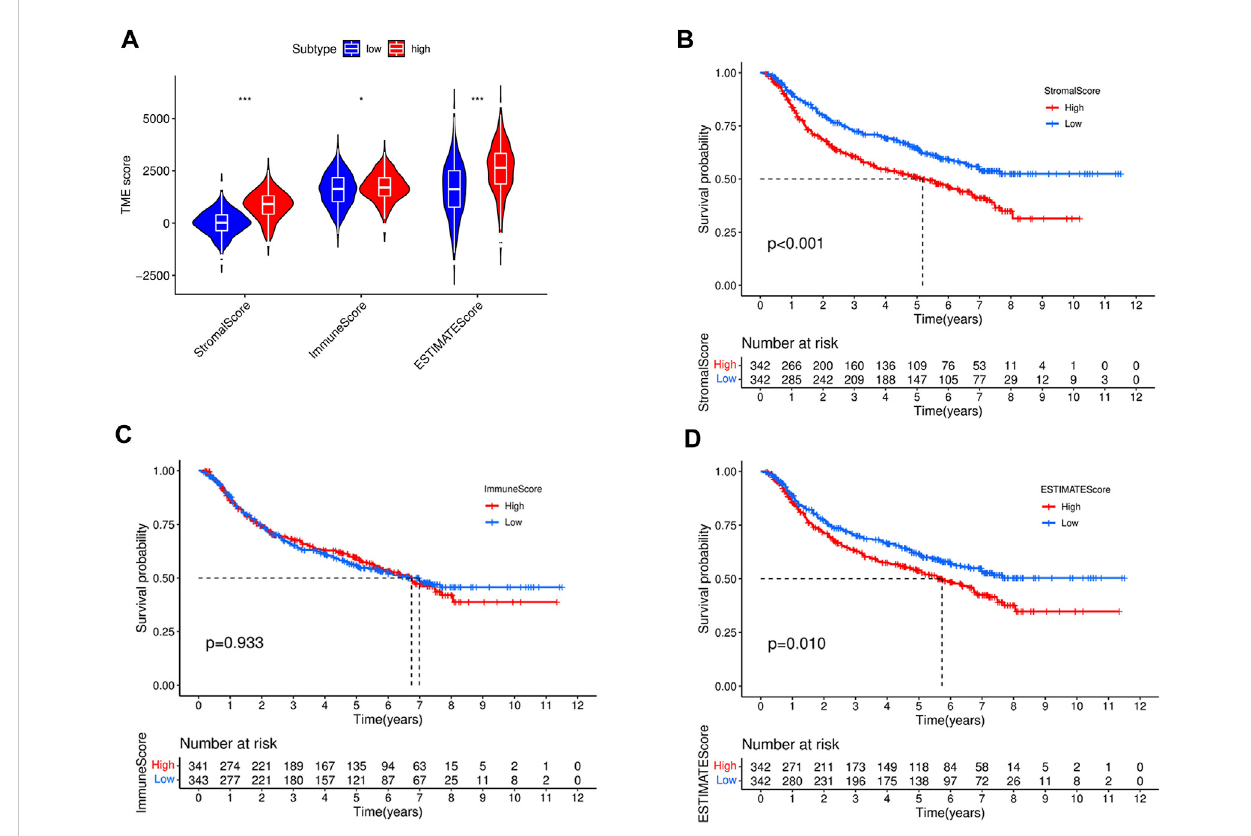
FIGURE 11 Comparisonofstromalscore,immunescore,ESTIMATEscores,betweenhigh-andlow-riskgroupsintheentirecohort (A) . (B) Kaplan – Meiercurves foroverallsurvivalof684GCpatientsaccordingtostromalscore.Log-ranktest, p < 0.001. (C) Kaplan – Meiercurvesforoverallsurvivalof684GCpatients accordingtoimmunescore.Log-ranktest, p =0.933. (D) Kaplan – Meiercurvesforoverallsurvivalof684GCpatientsaccordingtoESTIMATE score.Log- rank test, p = 0.01.